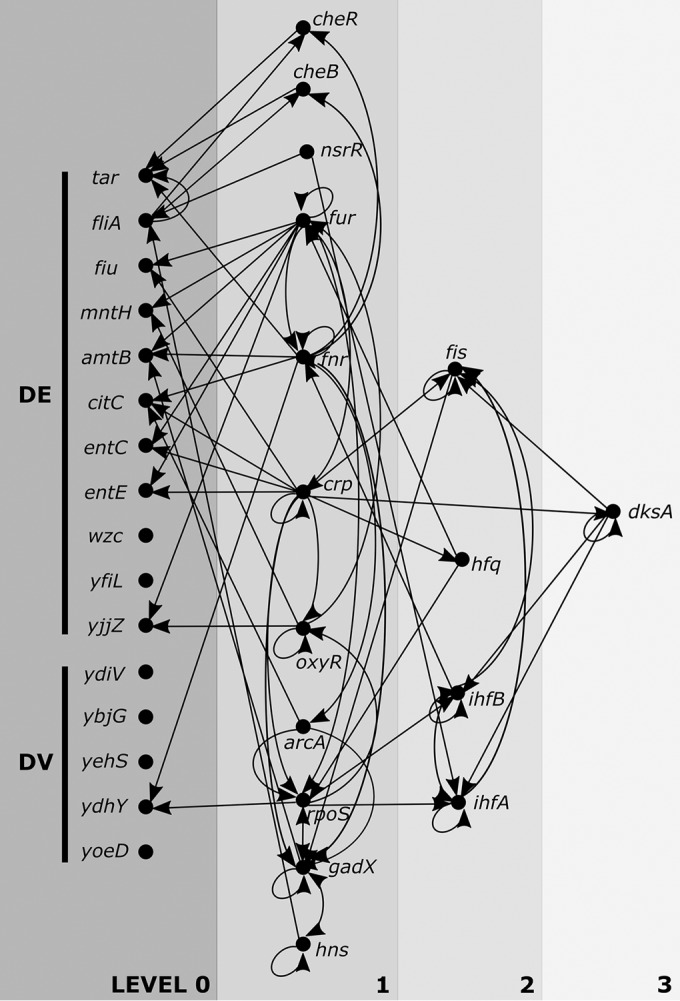
Upstream regulators of target genes. The diagram shows a simplified version of the network regulating target DE and DV genes. Here, only regulators that control two or more of the target genes (in level 0) are shown. Proceeding upstream (moving left to right), only regulators that control two or more of target genes and lower-level genes are included. Arrows indicate the direction of the regulation (i.e., cheR regulates tar).